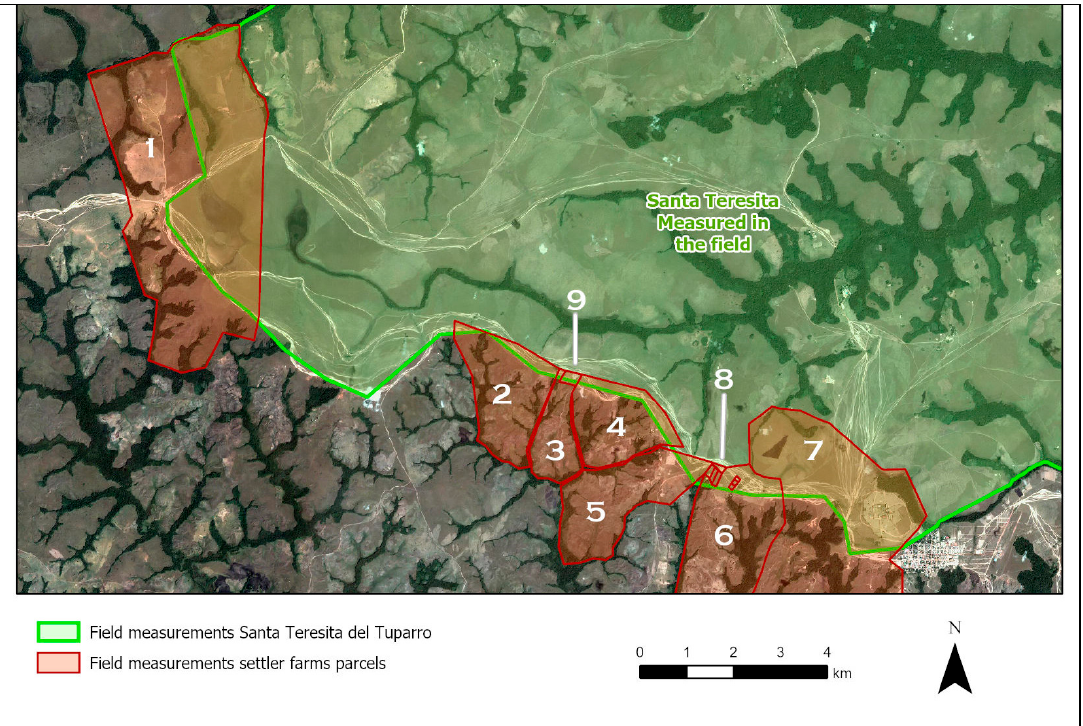
Figure 5. The Indigenous Santa Teresita del Tuparro reserve, as measured in the field by the Indigenous leaders compared to the parcels of the neighbouring settler farmers, as measured in the field: 1, La Guajira; 2, Buenavista; 3, Cuatro Vientos; 4, La Estancia; 5, Los Moriches; 6, Patio Bonito; 7, military base; 8, sold lots; 9, El Basurero (the municipal garbage